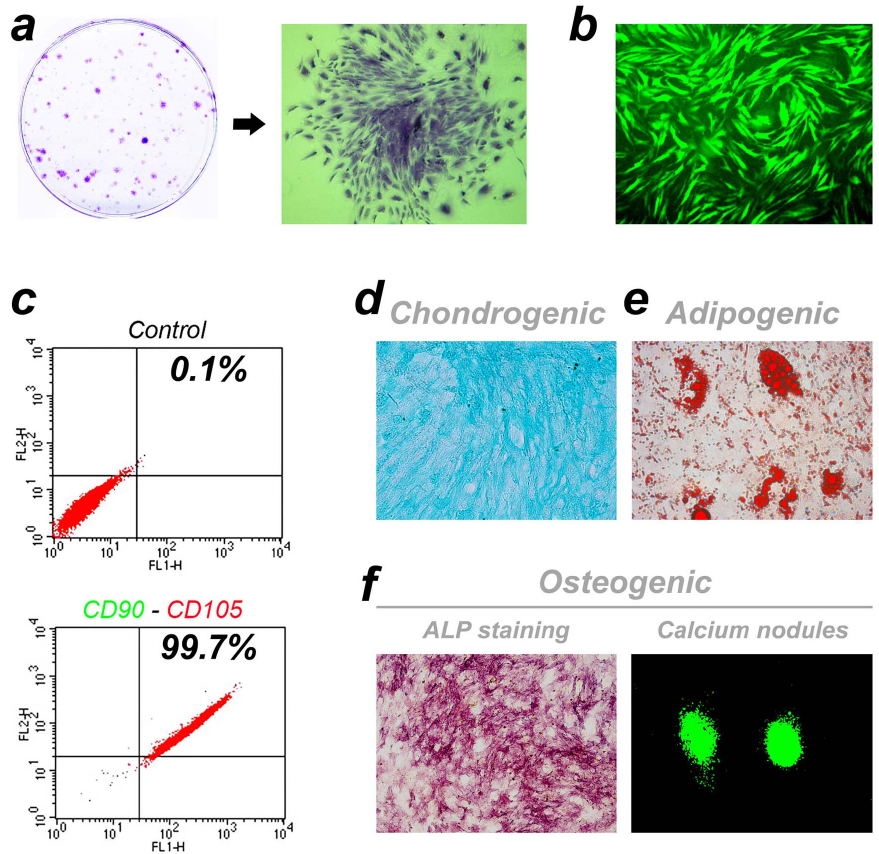
Figure 2. Cell culture and identification. (a) Cell colonies of different sizes observed after 7 days of primary culture. (b) Spindle shaped BMSCs of passage 2 labeled with GFP. (c) CD90 and CD105 co-expression by cells detected by FACS. (d-f) Multi-directional differentiation potential assay of rat BMSCs.